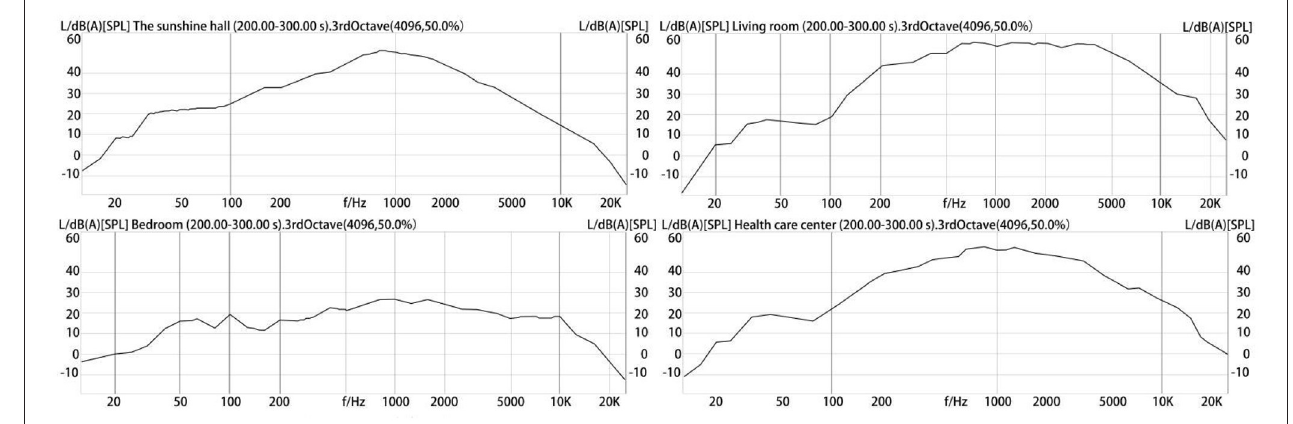
FIGURE 4 | Sound spectrum analysis of the nursing